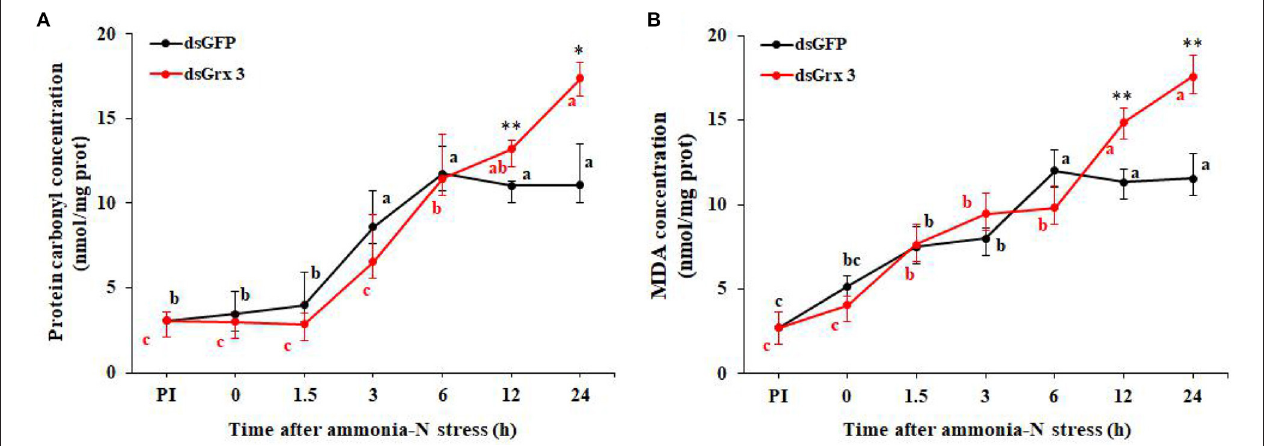
FIGURE 11 | Time course of protein carbonyl (A) and MDA contents (B) in LvGrx 3-interfered shrimps after exposure to ammonia-N ( n = 9). PI, pre-injection of dsRNA. Significant differences between dsGrx 3 and dsGFP-injected shrimps at the same exposure time are indicated with asterisks (* P < 0.05; ** P < 0.01; *** P < 0.001). The calculated data in the same group with different letters are significantly different ( P <